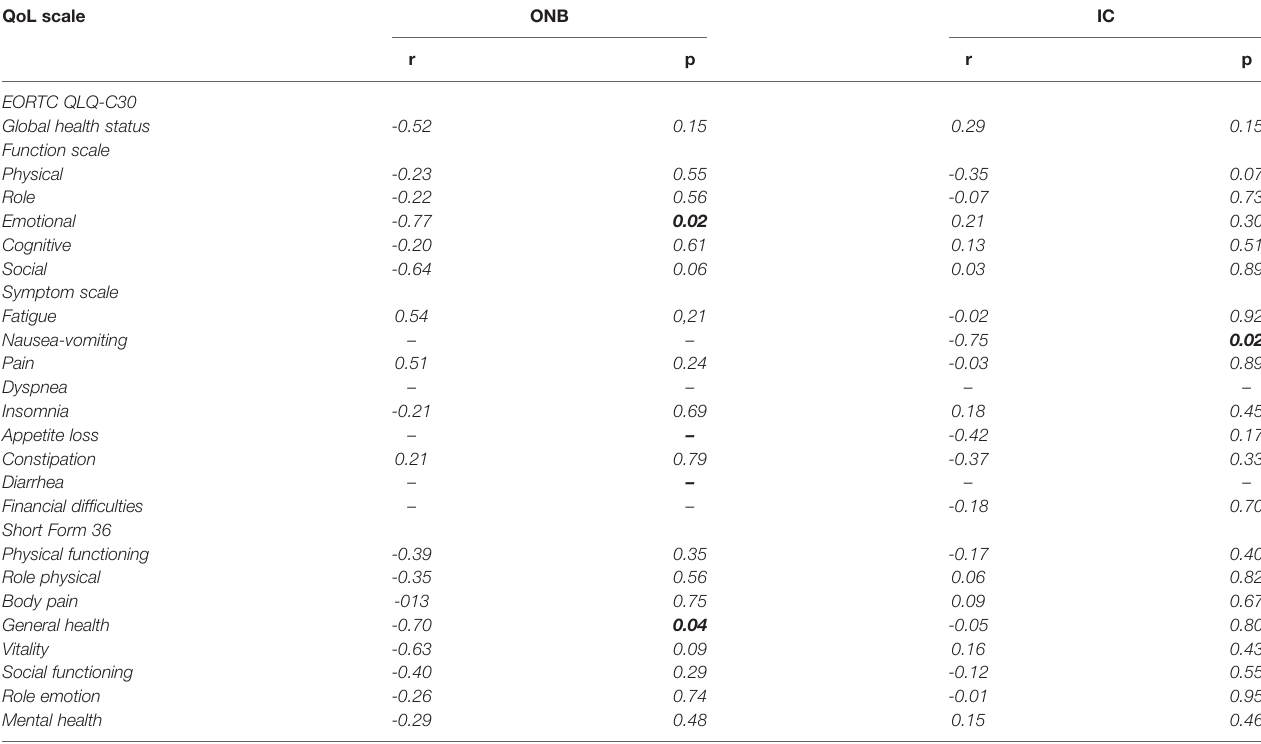
TABLE 3 | Spearman correlation analysis (r) of correlation between age and preoperative (baseline) 102EORTC QLQ-C30 and short form 36 scale. QoL